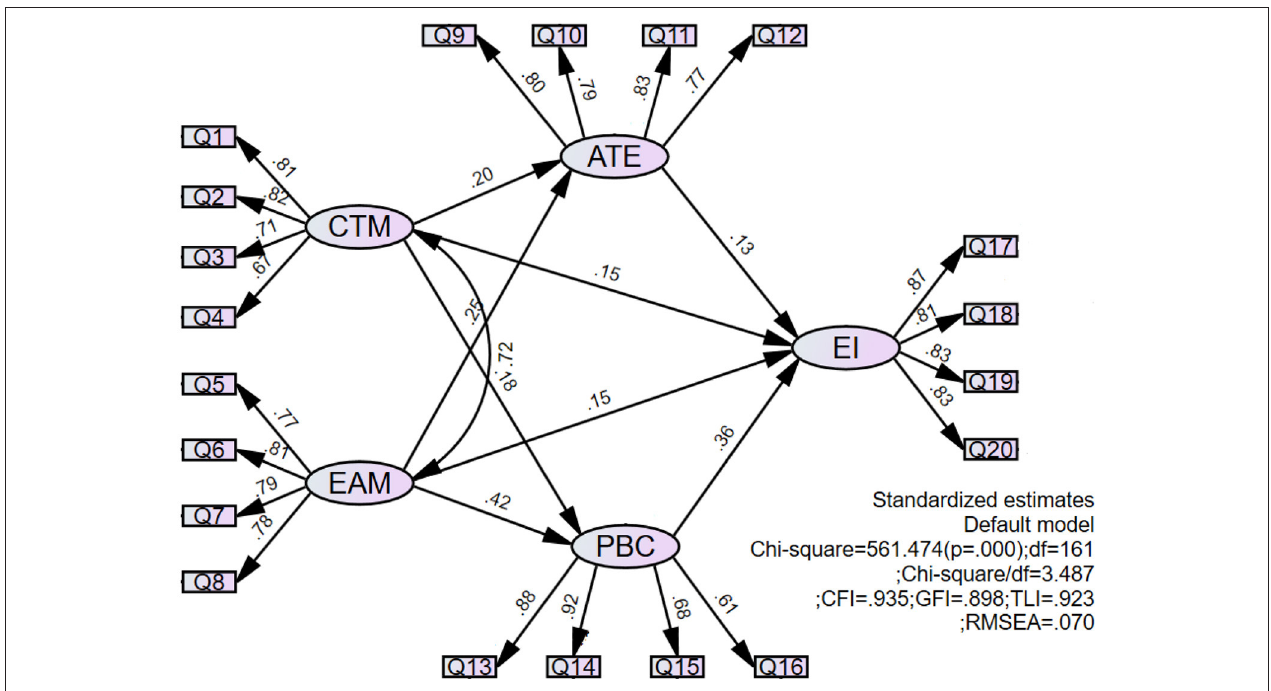
FIGURE 2 | Model test